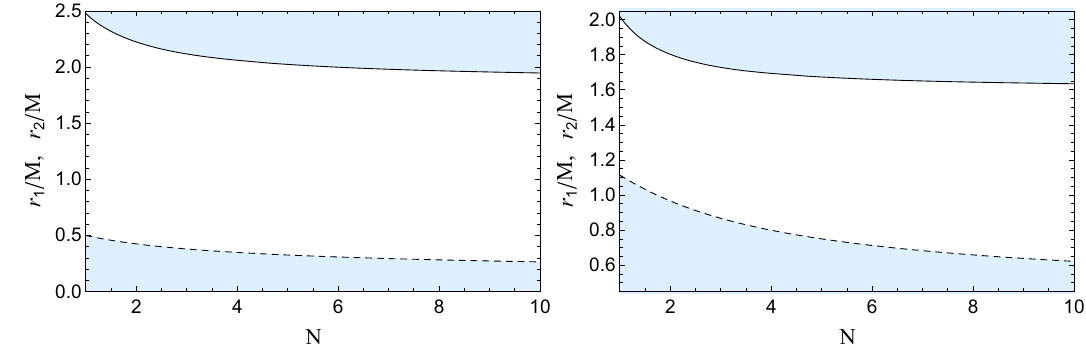
Fig. 9 DependenceoftheboundariesoftheSECintheregularrotating black hole spacetime in conformal gravity on the dimensionless param- eter N in the large L limit. Here we have a / M = 0 . 5 ( left panel ) and